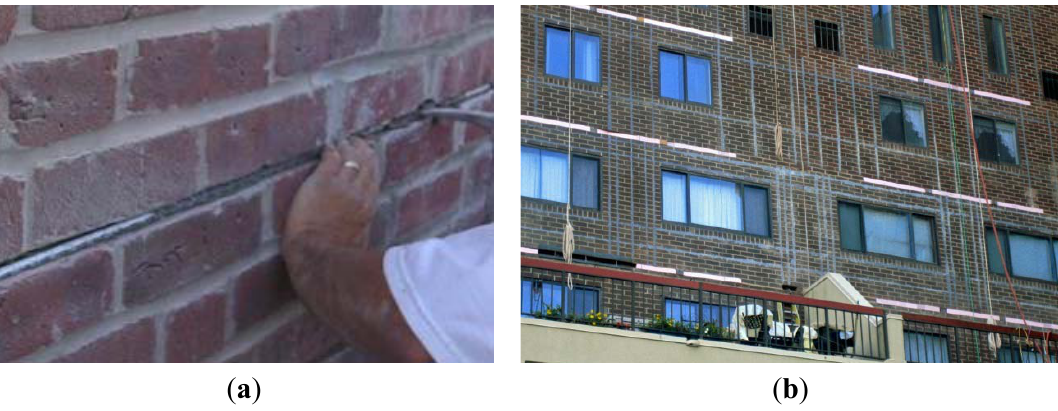
Figure 26. Structural FRP repointing in clay masonry walls: ( a ) Installation of an individual bar in an open joint; ( b ) View of the façade after completion of the